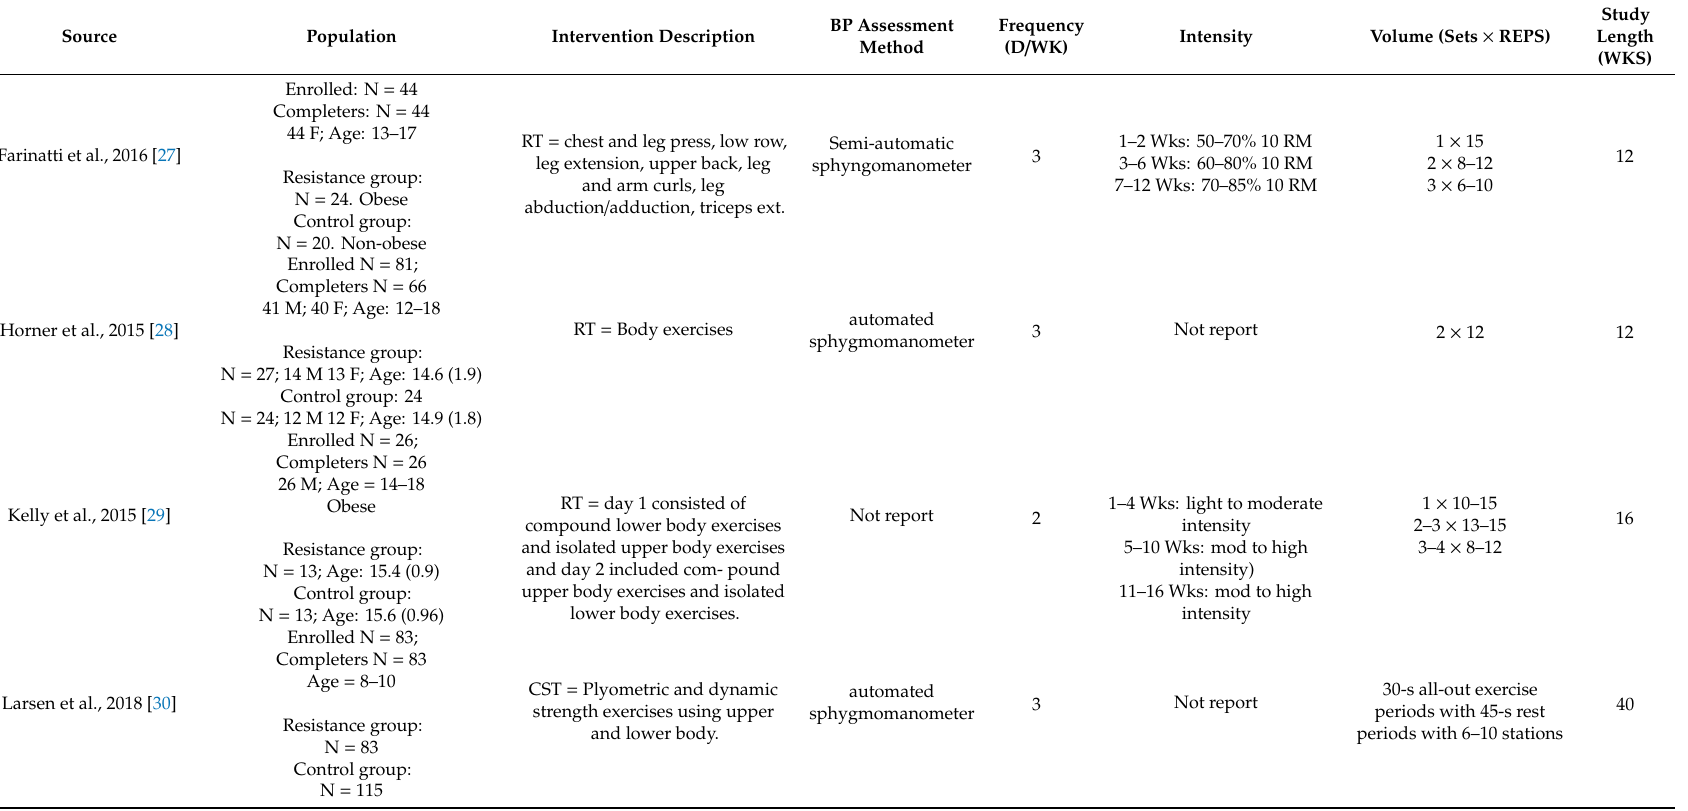
Table 1. Resistance Training Studies with Blood Pressure outcome